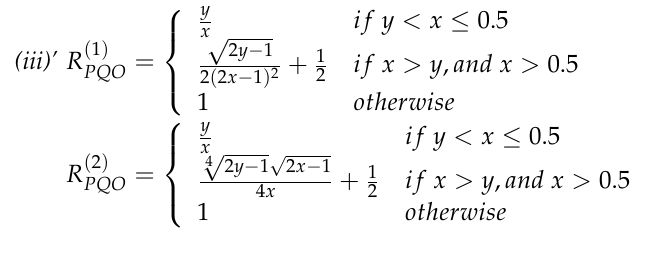
Figure 8. The graphs of ( ii ) (cid:48) R